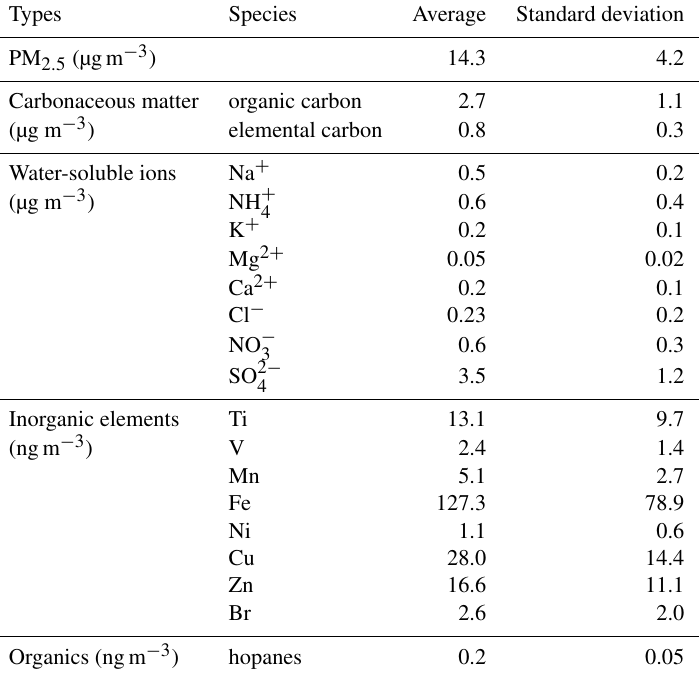
Table 2. The average mass concentrations of PM 2 . 5 , carbonaceous matter, water-soluble ions, inorganic elements and organics during the